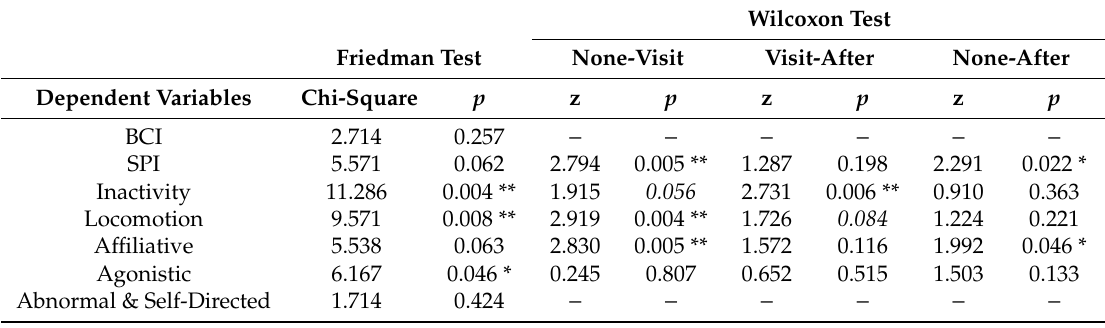
Table 4. Dependent variables a ff ected by the visitor presence condition, comparing the three sub categories (none, visit,